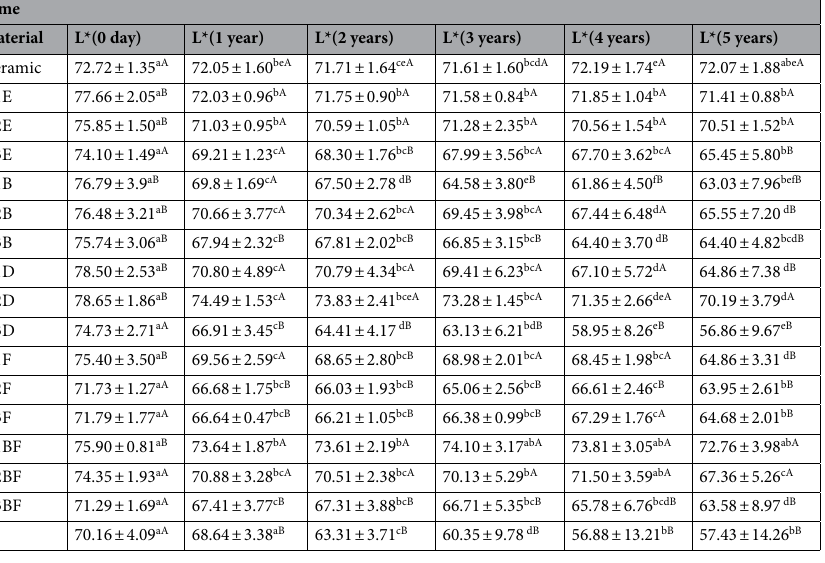
Table 3. Changes in lightness of the restorative materials and the ceramic across 5 years. Lower case letters indicate significant difference within the row ( p < 0.05). Upper case letters indicate significant difference within the column ( p <